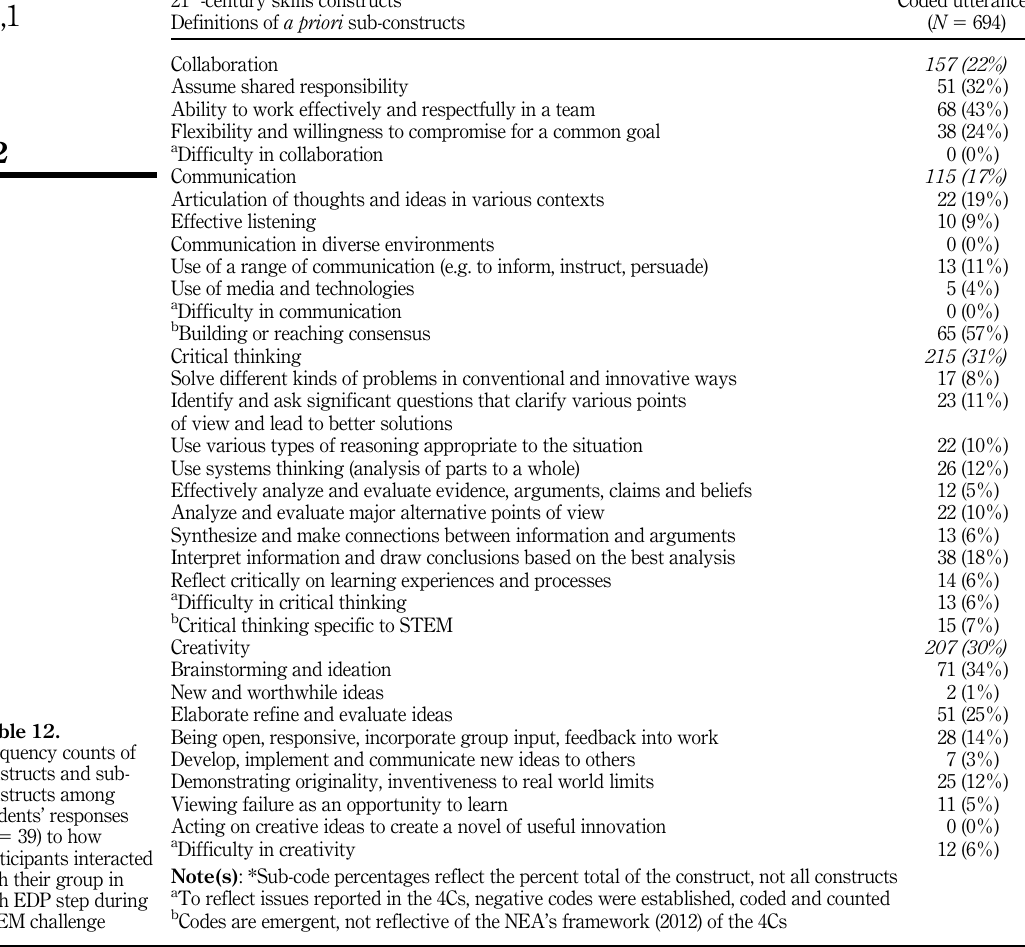
constructs and sub- constructs among students ’ responses ( N 5 39) to how participants interacted with their group